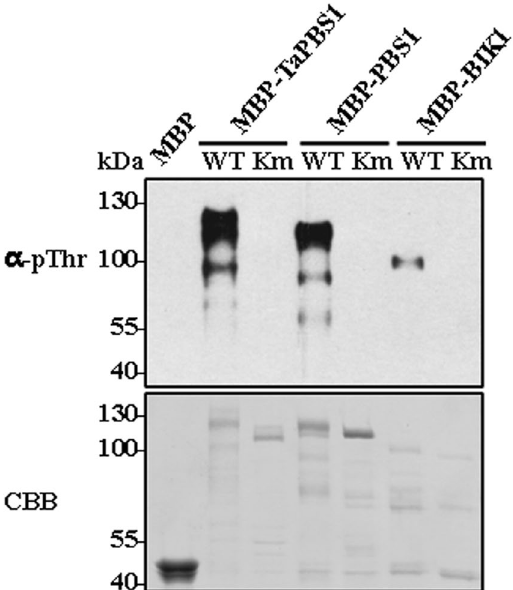
Figure 5. In vitro analysis of TaPBS1 autophosphorylation. An in vitro protein phosphorylation assay was performed by incubating MBP, MBP-TaPBS1, MBP-TaPBS1Km (K132A), MBP-PBS1, MBP-PBS1Km (K115N), MBP-BIK1, and MBP-BIK1Km (K105A) in the presence of ATP. Proteins were separated with SDS-PAGE, and the protein phosphorylation was detected by Western blot analysis with an anti-phospho-Thr (pThr) antibody (upper panel). The protein loading control was shown by Coomassie brilliant blue staining (CBB, lower